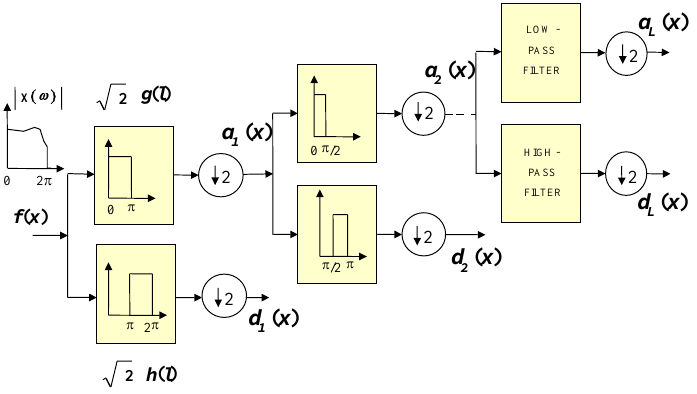
Figure 2. Implementation of the multiresolution analysis (MRA) based on a filter bank.